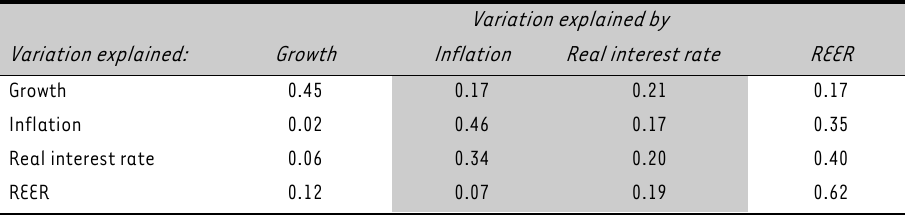
Source: Authors' calculations Variance decomposition for Namibia Variation explained: Growth Inflation Real interest rate Growth